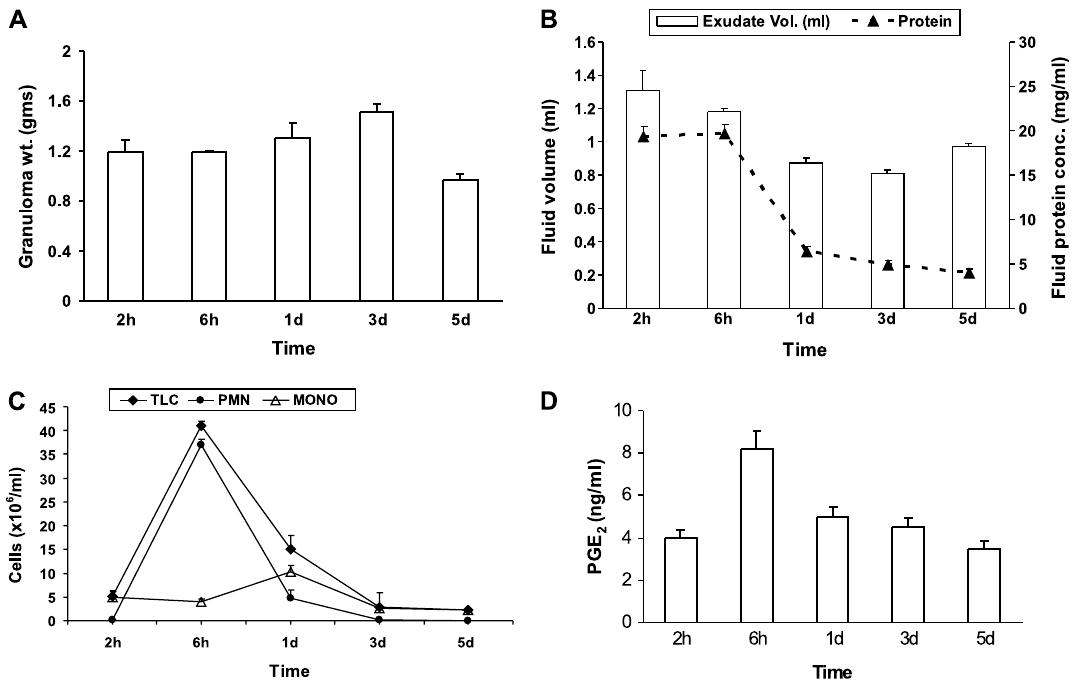
FIG. 1. Time course of granulation tissue formation (A), fluid exudation (B), cellular infiltration (C) and PGE 2 concentration (D) in the rat air-pouch after injection of 10 mg DL. Results are expressed as mean 9 / standard error of the